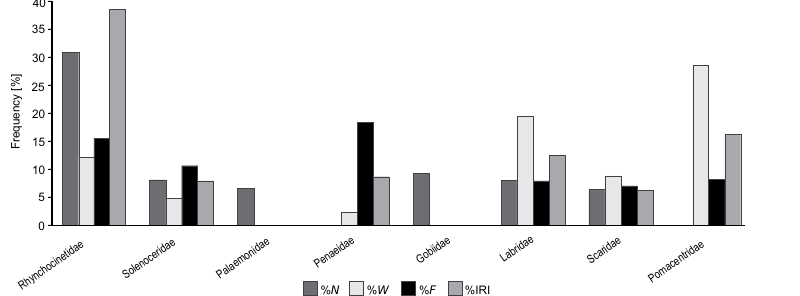
Fig. 3. Diet composition of red lionfi sh, Pterois volitans , on the family level; % N = percentage by number, % W = percentage by weight, % F = frequency of occurrence, %IRI = index of relative importance %IRI